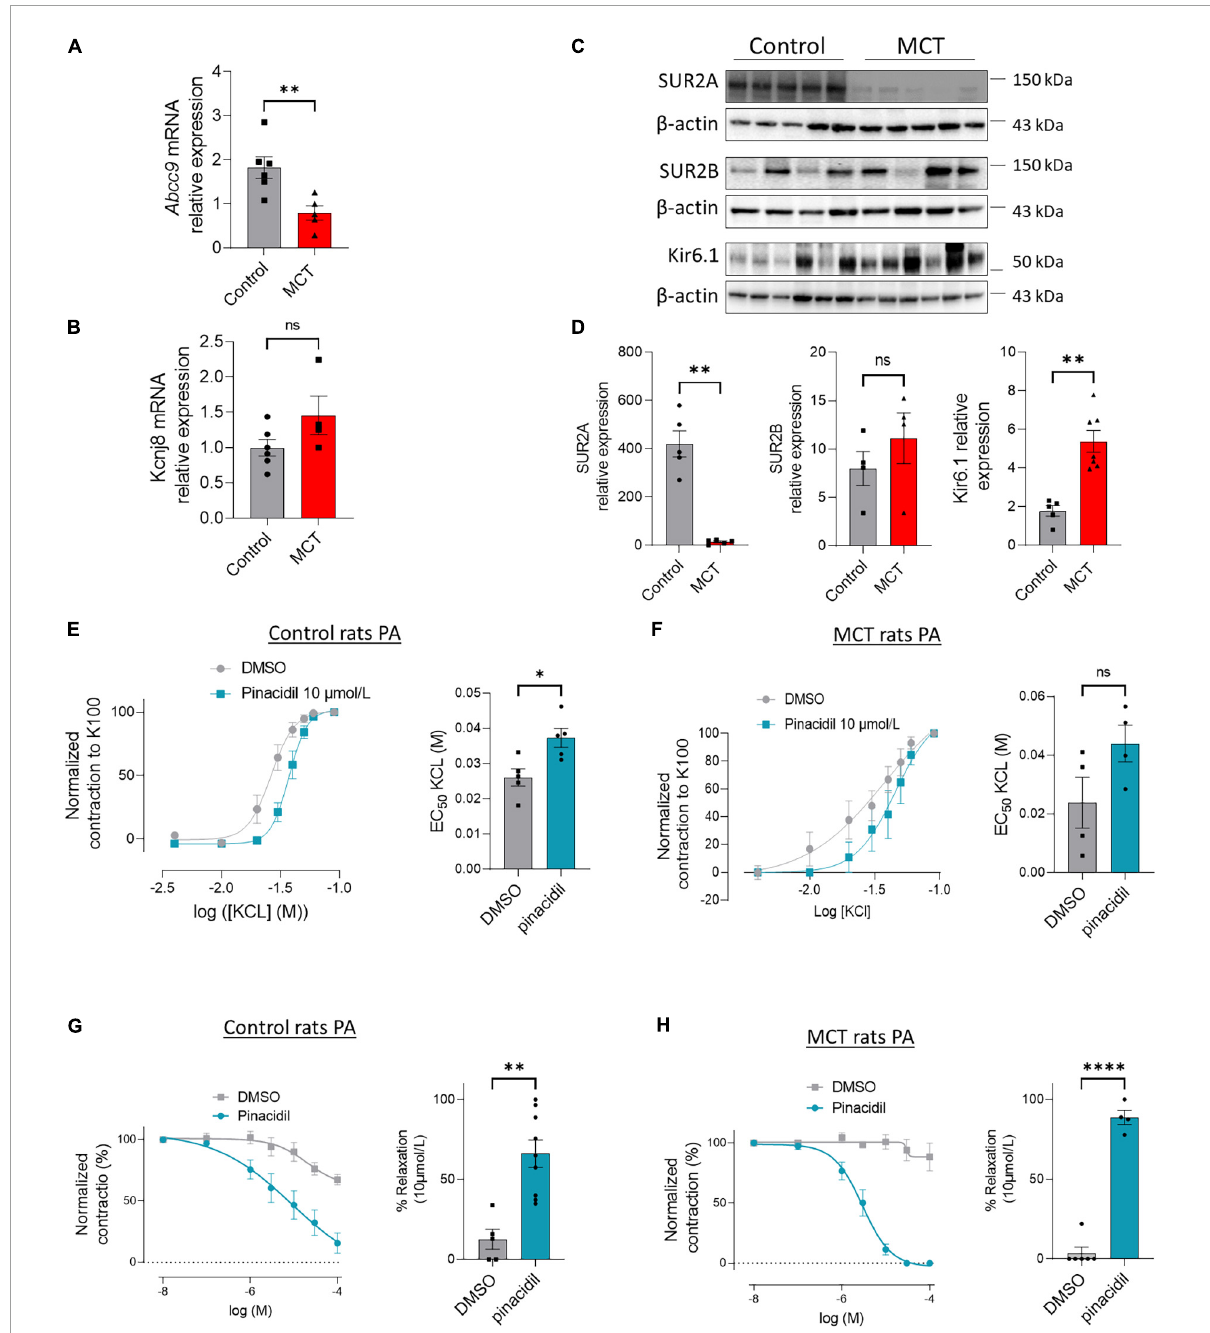
FIGURE4 Pharmacological activation of SUR2 produces PA relaxation in control and MCT-PH rats. (A,B) ABCC9 and KCNJ8 mRNA expression was quantified in the lungs of control and MCT-PH rats ( n = 4–6). (C) Representative western blots of SUR2A, SUR2B, and Kir6.1 in lungs from control and MCT-PH rats (3 weeks). (D) Quantification of SUR2A, SUR2B, and Kir6.1 expression in lungs of controls and MCT-PH rats ( n = 4–6). (E) Dose-response curve (normalized to K100) was established by increasing concentrations of potassium chloride (KCl) to isolated PA from control rats in the presence of DMSO or pinacidil (SUR2 activator, at 10 µ mol/L). Corresponding quantification EC50 values ( n = 5 rats). (F) Dose-response curve (normalized to K100) was established by increasing concentrations of potassium chloride to isolated PA from control and MCT-PH rats in the presence of pinacidil at 10 µ mol/L. Corresponding quantification EC50 values ( n = 4 rats). (G) Dose-response to pinacidil (100 nmol/L to 100 µ mol/L) and DMSO on precontracted control rat PA by 1 µ mol/L of U46619. Graphics represent the contraction percentage at 10 µ mol/L of PA treated with pinacidil or DMSO ( n = 5–9 rats). (H) Dose-response to pinacidil (100 nmol/L to 100 µ mol/L) and DMSO on pre-contracted MCT-PH rat PA by 1 µ mol/L of U46619 ( n = 4–5 rats). Graphics represent the contraction percentage at 10 µ mol/L of PA treated with pinacidil or DMSO. ns: non-significant. ∗ p < 0.0 5, ∗∗ p < 0.01 , ∗∗∗∗ p < 0.0001